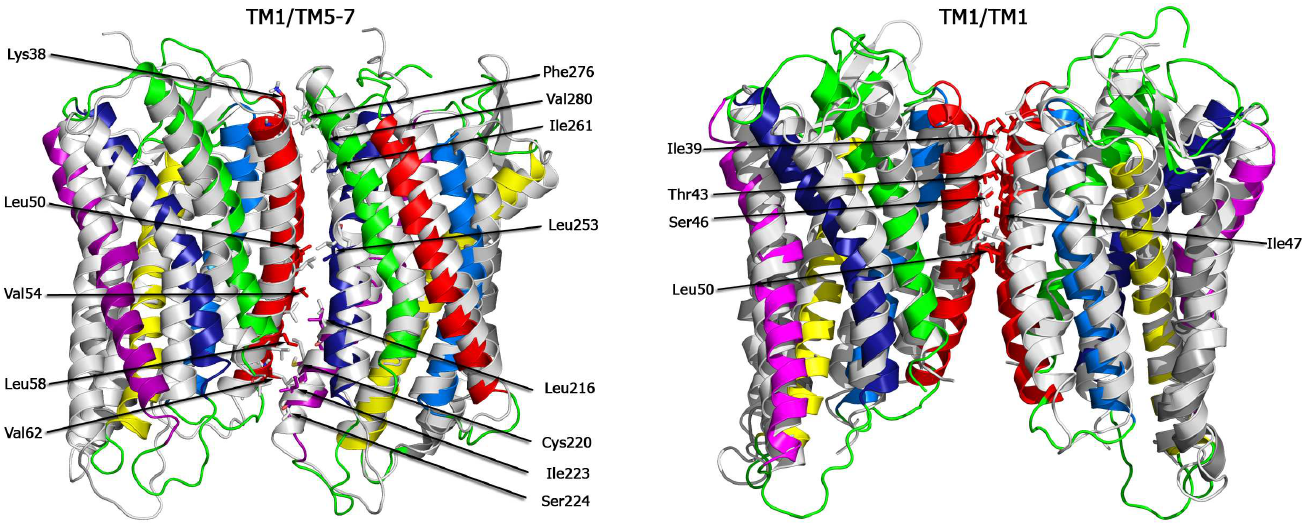
Fig 3. TM1/TM5-7 and TM1/TM1 dimer interfacesand structure alignments. Structure alignments between spontaneously formed TM1/TM5-7 dimer (a) as well as TM1/TM1 dimer (b), obtained from a 3 μ s simulation in pure POPC and backmapped to atomistic resolution(colored TM helices), and the crystal structures of TM1/TM5-7 and TM1/TM1 found in PDB-entries 3OE8 and 3OE9, respectively (light grey). The interactingresidues are highlightedas sticks and labeled.